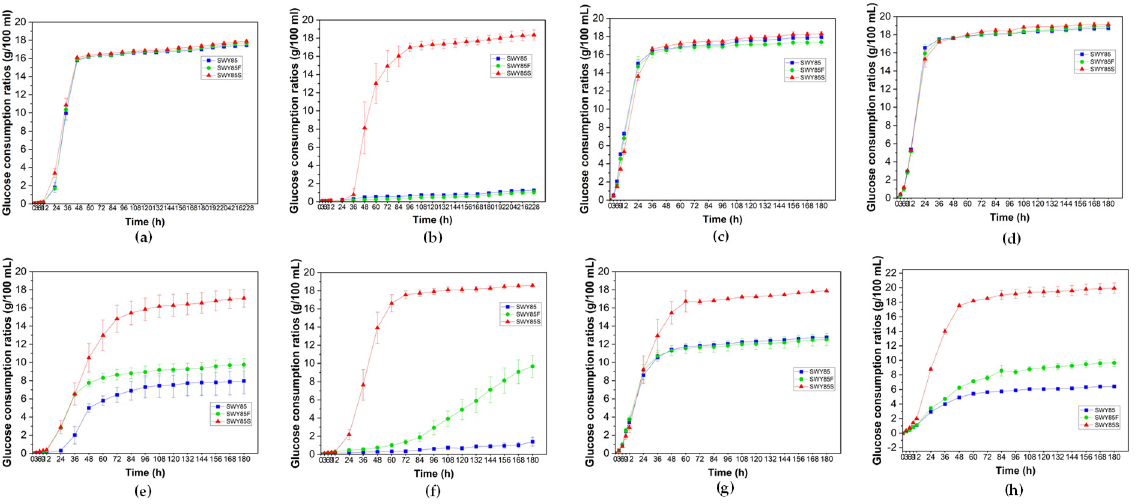
Figure 6. The glucose consumption ratios of the three strains in high-glucose YPD medium acidified with hydrochloric acid (HA) to pH 2.7 ( a , c ) and pH 2.5 ( e , g ), and acidified with malic acid (MA) to pH 2.7 ( b , d ) and pH 2.5 ( f , h ) during anaerobic fermentation. Panels ( a , b , e , f ): cell-inoculation fermentations (CIFs), cells in the stationary growth phase were collected from 100 µL of culture medium, and inoculated into the fermentation medium. Panels ( c , d , g , h ): cell-transferring fermentations (CTFs), 363 mg of wet cells in the stationary growth phase were transferred into the fermentation medium.